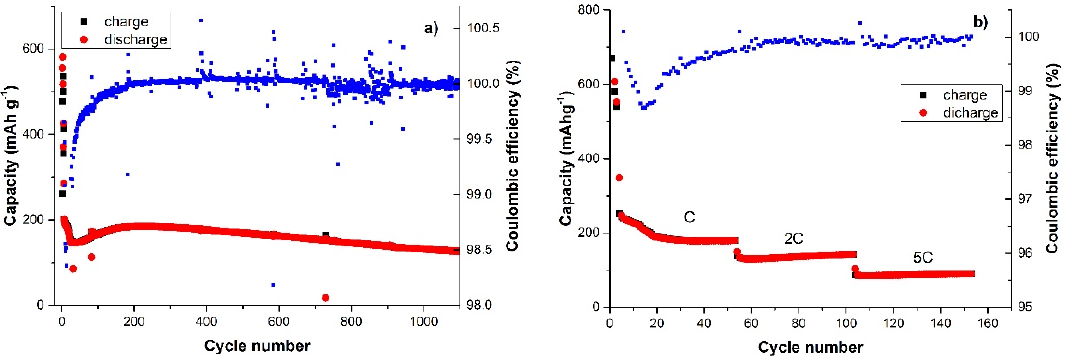
Figure 7. Capacity vs. cycle number at: ( a ) 1C rate for 1100 cycles; and ( b ) at 1C, 2C and 5C current rate for 50 cycles each.